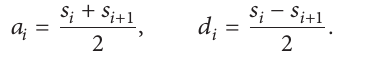
Figure 3: Human and elephant loss in Coimbatore